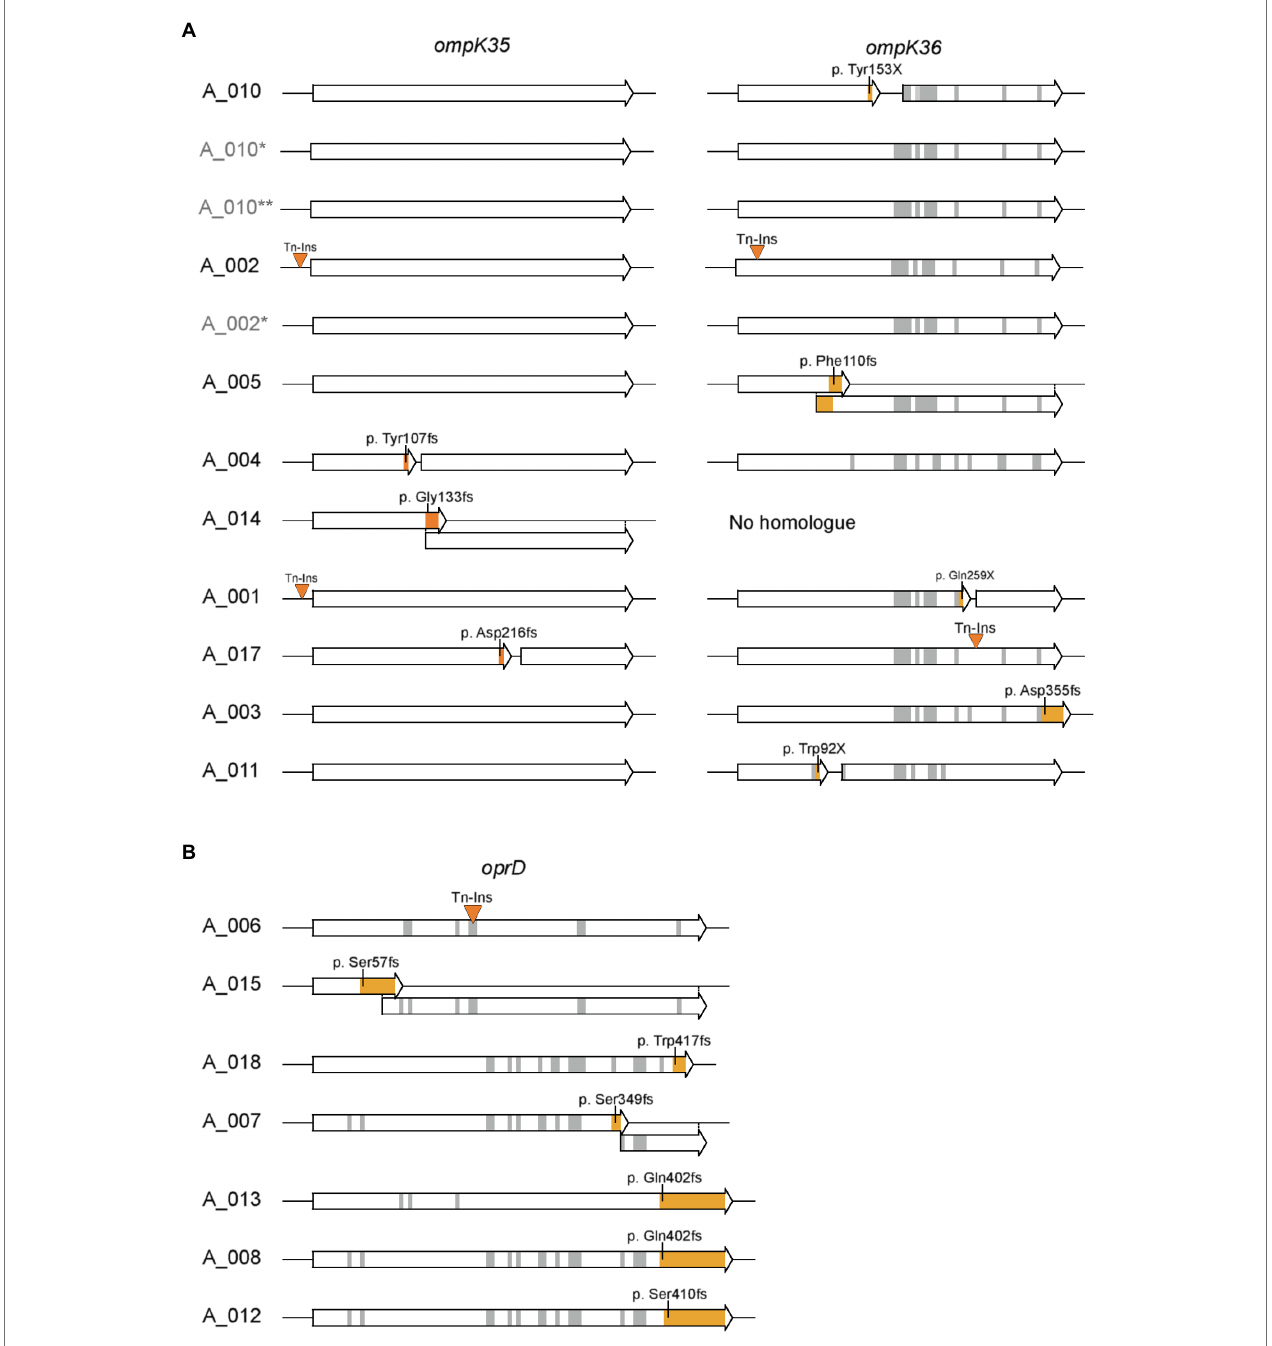
FIGURE 5 | Sequence analysis of porins involved in carbapenem resistance. (A) Sequences of ompK35 and ompK36 for K. pneumoniae isolates and (B) sequences of oprD for P. aeruginosa isolates are shown. Insertions of transposons and mutations leading to a frameshift or insertion of a premature stop codon are highlighted in orange. Gray areas represent other amino acid changing mutations. Amino acid positions and sequence refer to ompK35 and ompK36 of K. pneumoniae ATCC43816 (CP009208.1) or oprD of P. aeruginosa PAO1, respectively. Isolates labeled in light gray (A_002*, A_010*, and A_010**) indicate carbapenem-sensitive isolates from the respective patient obtained prior or post the CRGN